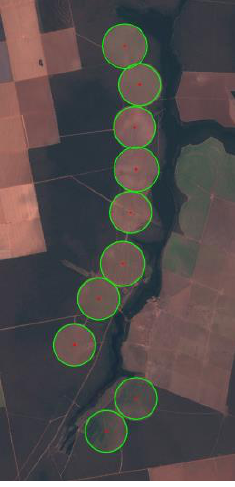
Figure 7. Center pivot irrigation systems accurately detected by Hough circle